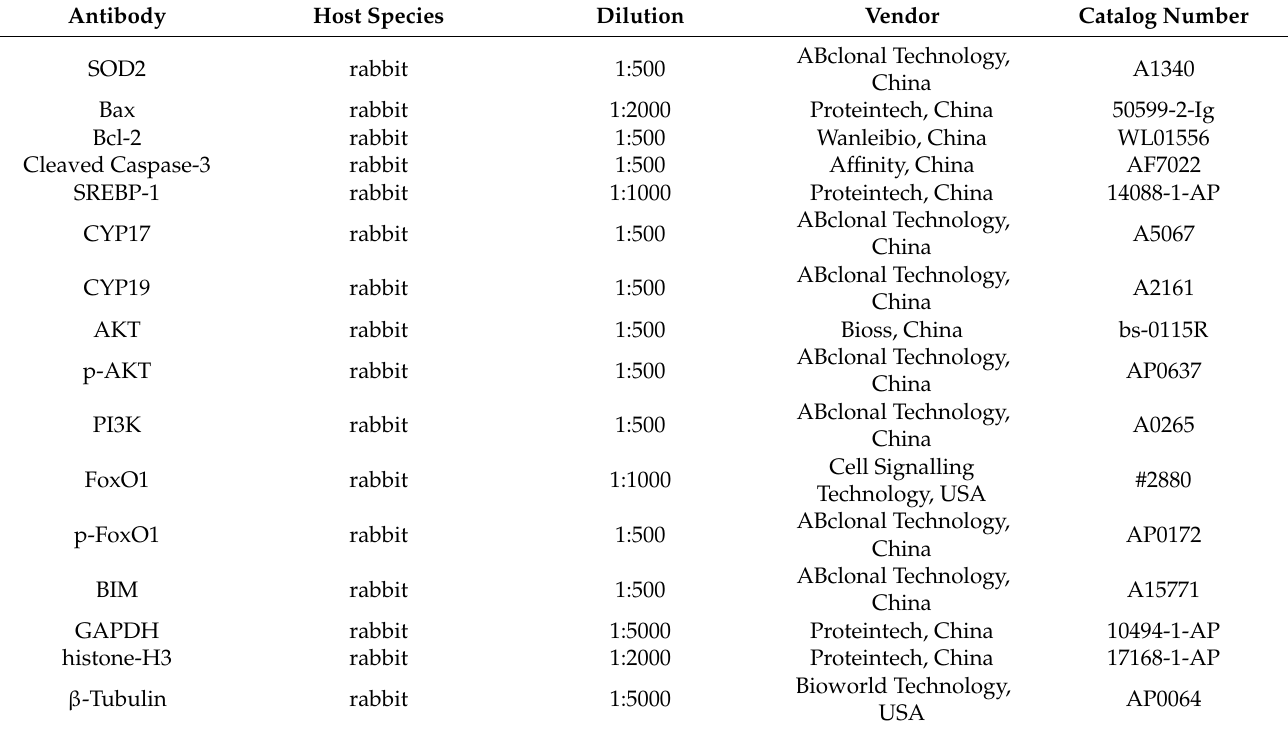
Table 2. Antibodies used in this experiment for Western